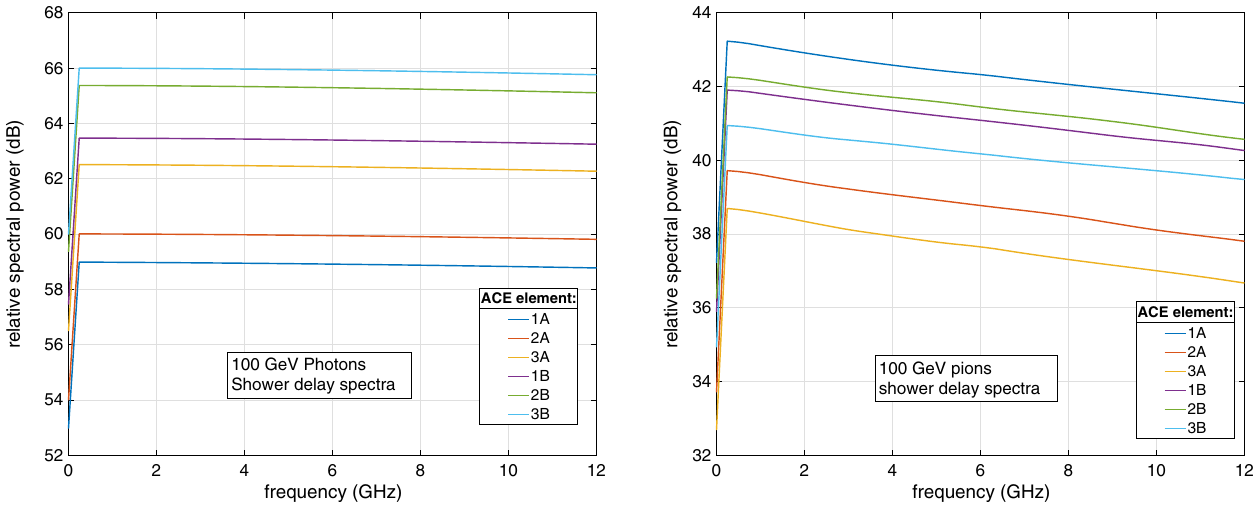
FIG. 24. Relative frequency spectral power for the time delay spectra shown previously. Left, for photon showers, and right, for pion